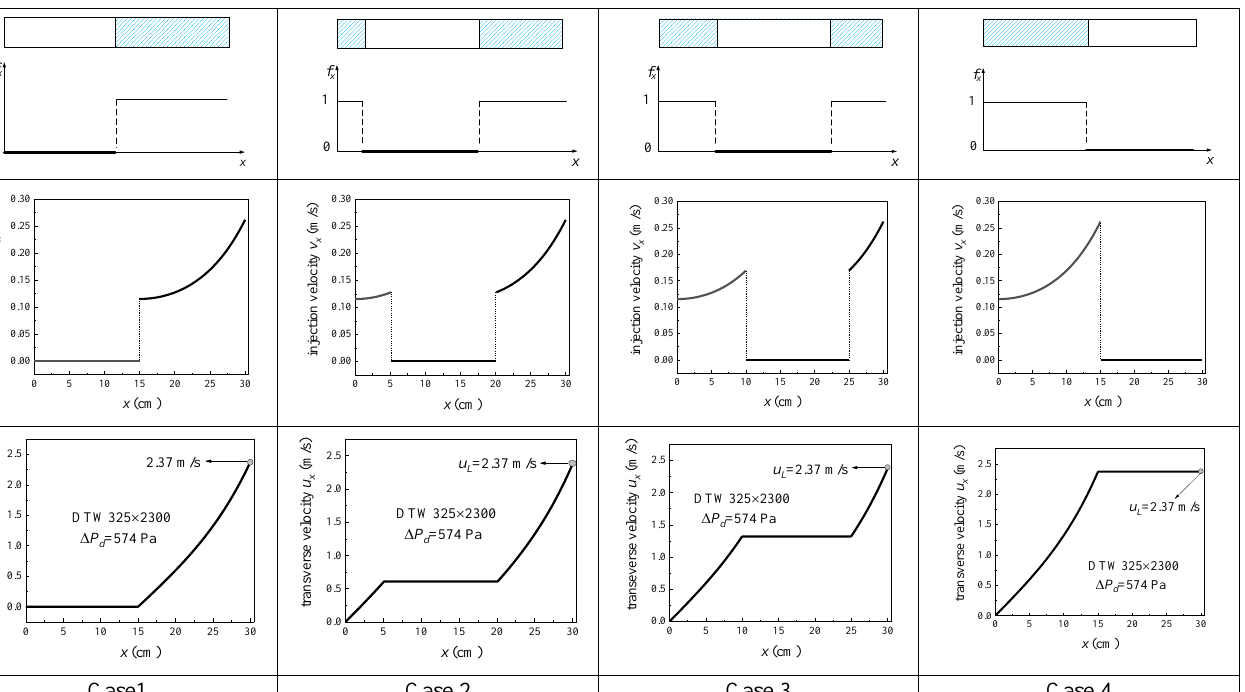
Figure 7. Comparison of cases with a single bubble at four different locations.